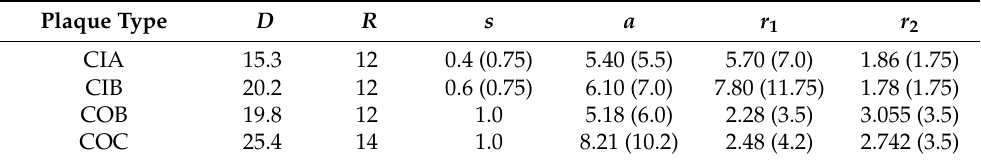
Figure 5. Pairs of pictures of the asymmetric plaques in their molds with the superposition of the geometric forms, generated with the Geogebra program, used to parameterize the cutout. For each plaque type, the official ( left image ) and modified parameters ( right image ) are presented in adjacent images. Table 3. Geometric parameters of the asymmetric plaques with the modified values derived from this work, with D being the plaque diameter, R the curvature radius, s the size of the inactive rim, a the notch depth, r 1 the notch curvature radius, and r 2 the curvature radius of the notch edges. All numeric values are expressed in mm. For the modified parameters, their official values are given in brackets for comparison.